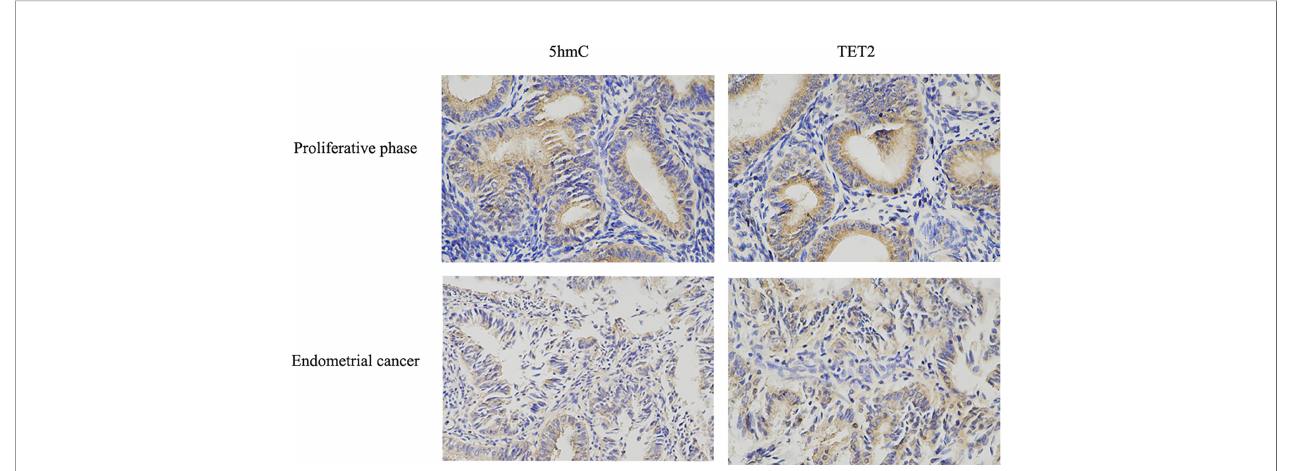
FIGURE 2 | TET2 and 5hmC were low-expressed in endometrial cancer. The expression of TET2 and 5hmC in proliferative phase endometrial tissue and EC tissue was assessed using IHC staining. Representative images were captured at ×400 magni fi cation. TET2 and 5hmC IHC scores in EC tissues compared with proliferative phase endometrial tissues were